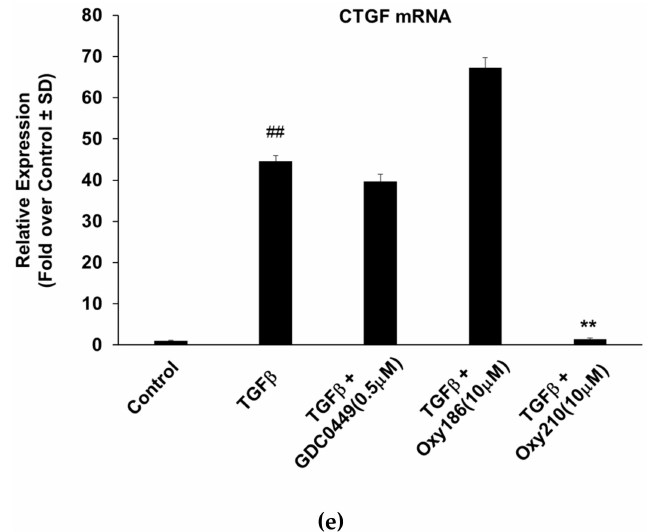
Figure 4. Inhibition of ligand-induced Hedgehog and TGF β signaling in mouse fibroblast cells. NIH3T3 cells were pretreated for 2 h with Oxy210 or various inhibitors as indicated in DMEM containing 5% FBS. Next, cells were treated with CAPAN-1 conditioned medium (CM) in the absence or presence of oxysterols or inhibitors. After 72 h, RNA was extracted and analyzed by Q-RT-PCR for the expression of Hh target genes Gli1 and Ptch1 and normalized to Oaz1 expression ( a , b ). ( c , e ) NIH3T3 cells were treated in DMEM containing 0.1% BCS overnight and then pretreated for 2 h with the inhibitors as indicated in DMEM containing 0.1%BCS. The cells were then treated with TGF β (20ng / mL) in the absence or presence of the compounds. After 48 h, RNA was extracted and analyzed by Q-RT-PCR for the expression of TGF β target genes as indicated and normalized to Oaz1 expression. ( d ) NIH3T3 cells cultured in 24 well-plates were transfected with a Smad response element reporter (SBE-Luciferase) plasmid and a pTK-Renilla-Luciferase plasmid. 6 hrs after transfection, cells were treated with the test agents as indicated for 48 hrs. Luciferase activity was measured and normalized to the Renilla luciferase activity. Data from a representative experiment are reported as the mean of triplicate determinations ± SD (** p < 0.01 vs. CM ( a , b ) or TGF β ( c , d and e ) treated cells; ## p < 0.01 vs.